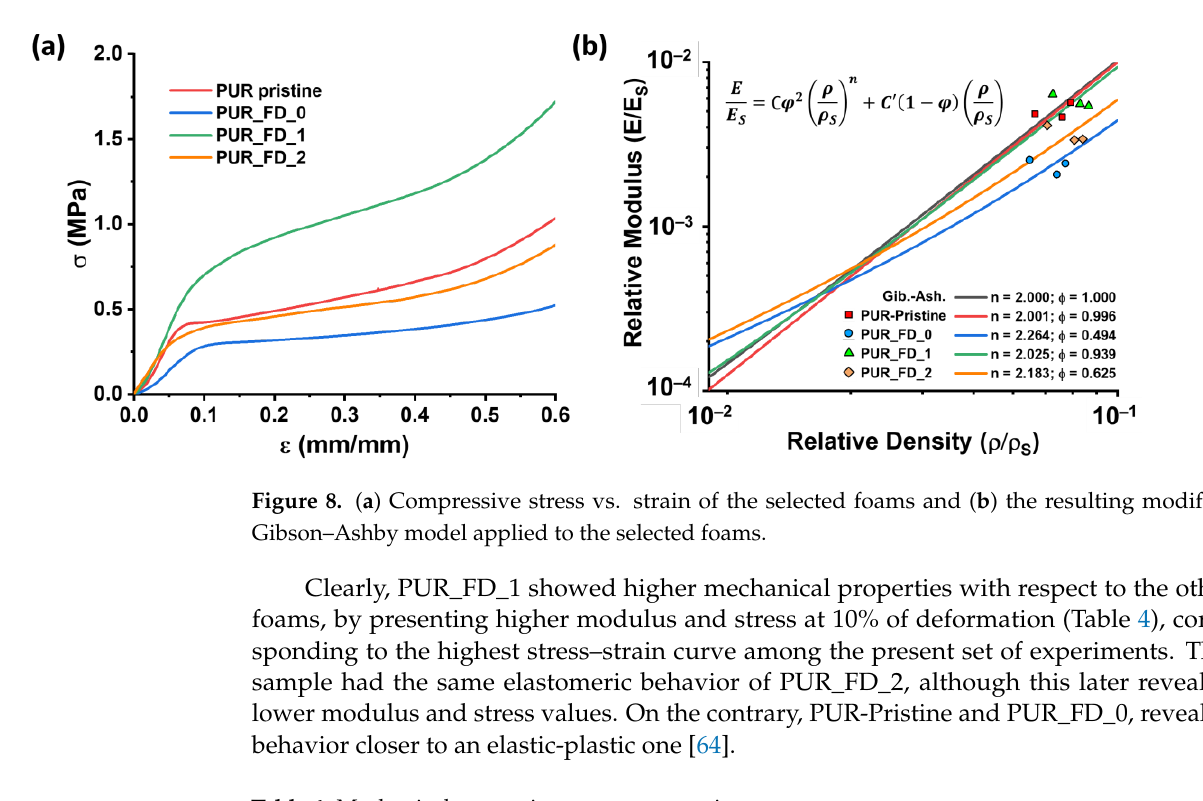
Table 4. Mechanical properties upon compression